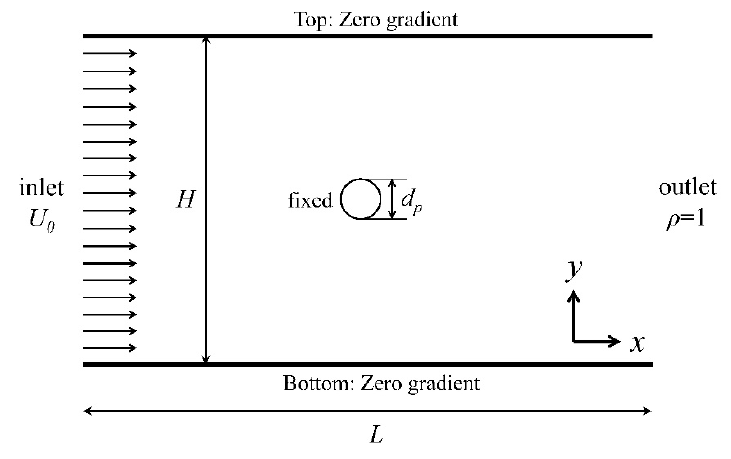
Figure 11. Schematic of flow past a stationary particle.